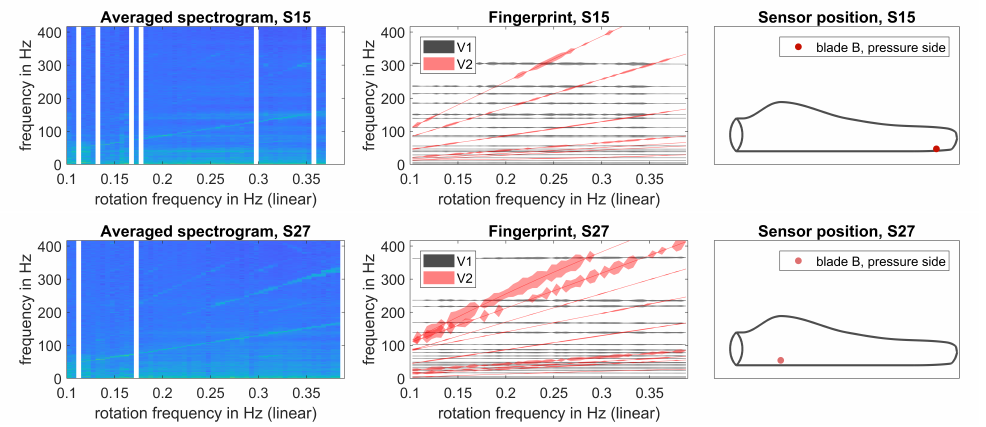
Figure 13. Fingerprint results for Sensors S 15 ( top ) and S 27 ( bottom ) mounted on tip and root of the same blade on Turbine 2. ( Left ) Linear-scale spectrogram with colour corresponding to logarithmic amplitude. ( Middle ) Extracted fingerprints, both Type 1 and Type 2 vibrations displayed. ( Right ) Sensor positions on the blade.